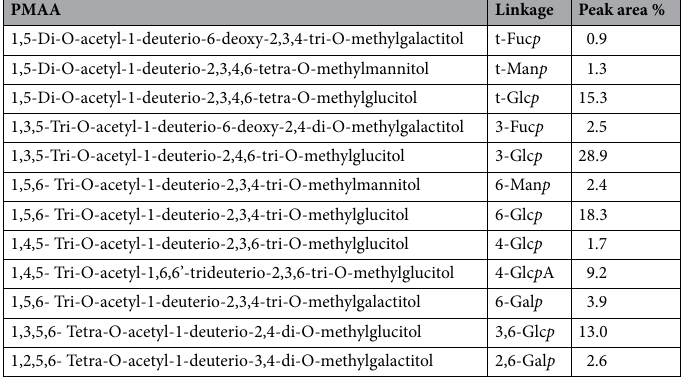
Table 1. Glycosyl linkage analysis of EtGIPL1a by partially methylated alditol acetates. For clarity, residues found at < 1% were omitted.